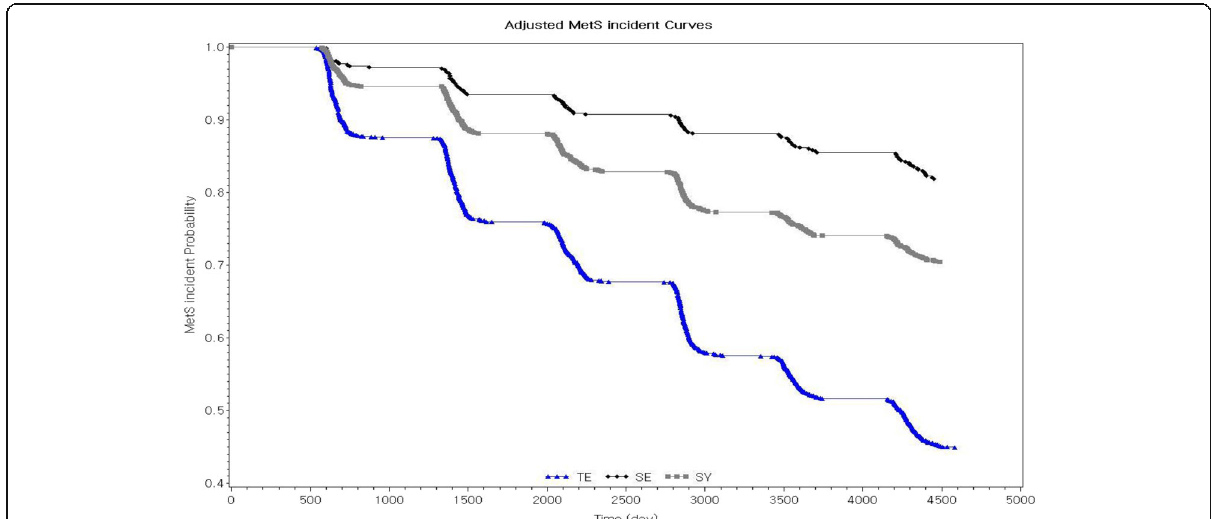
Fig. 1 Estimated risk of the incident metabolic syndrome ( n = 3529). The risk was adjusted for age, sex, BMI, education, income, smoking, drinking, and physical